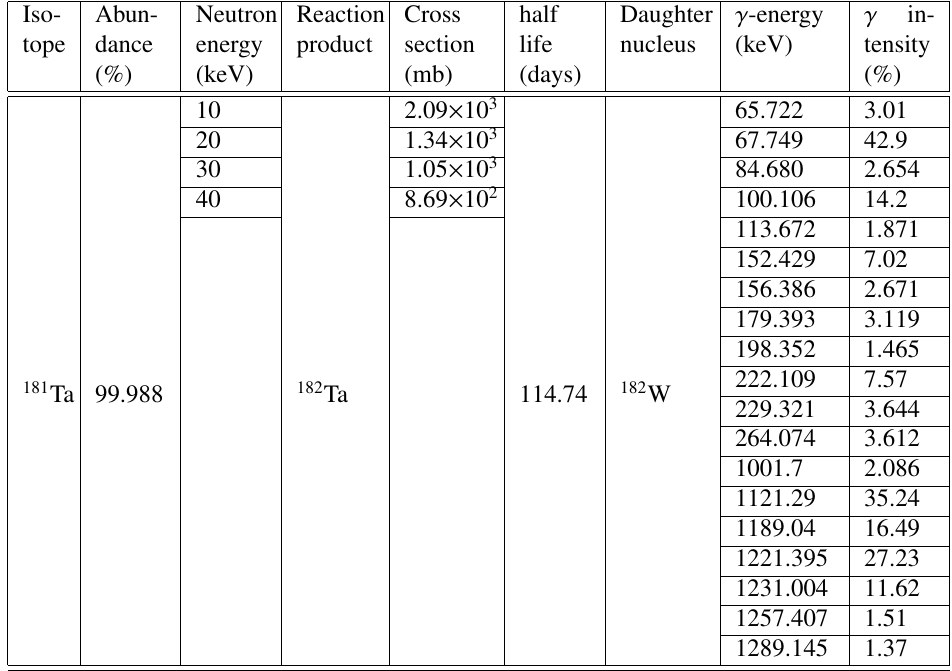
of gamma having intensity greater than 1% along with cross-section value as calculated by TALYS for di ff erent neutron energy is shown in Table 2. Table 2. List of gamma rays due to production of 182 Ta. Cross- section presented in the list